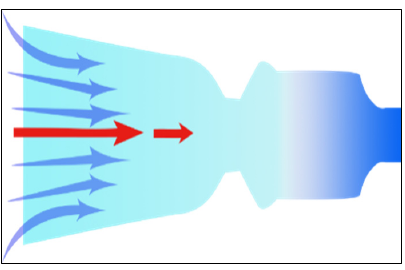
Figure 10. A structure that delivers air to reaction chamber.